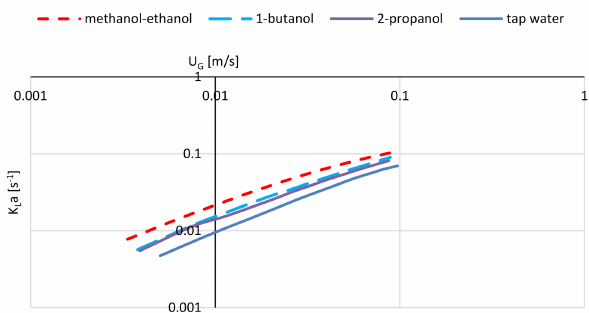
Figure 37. Influence of the gas phase on k L a —data from Ozturk et al. [173].